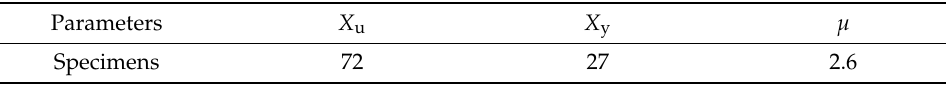
Table 5. Ductility